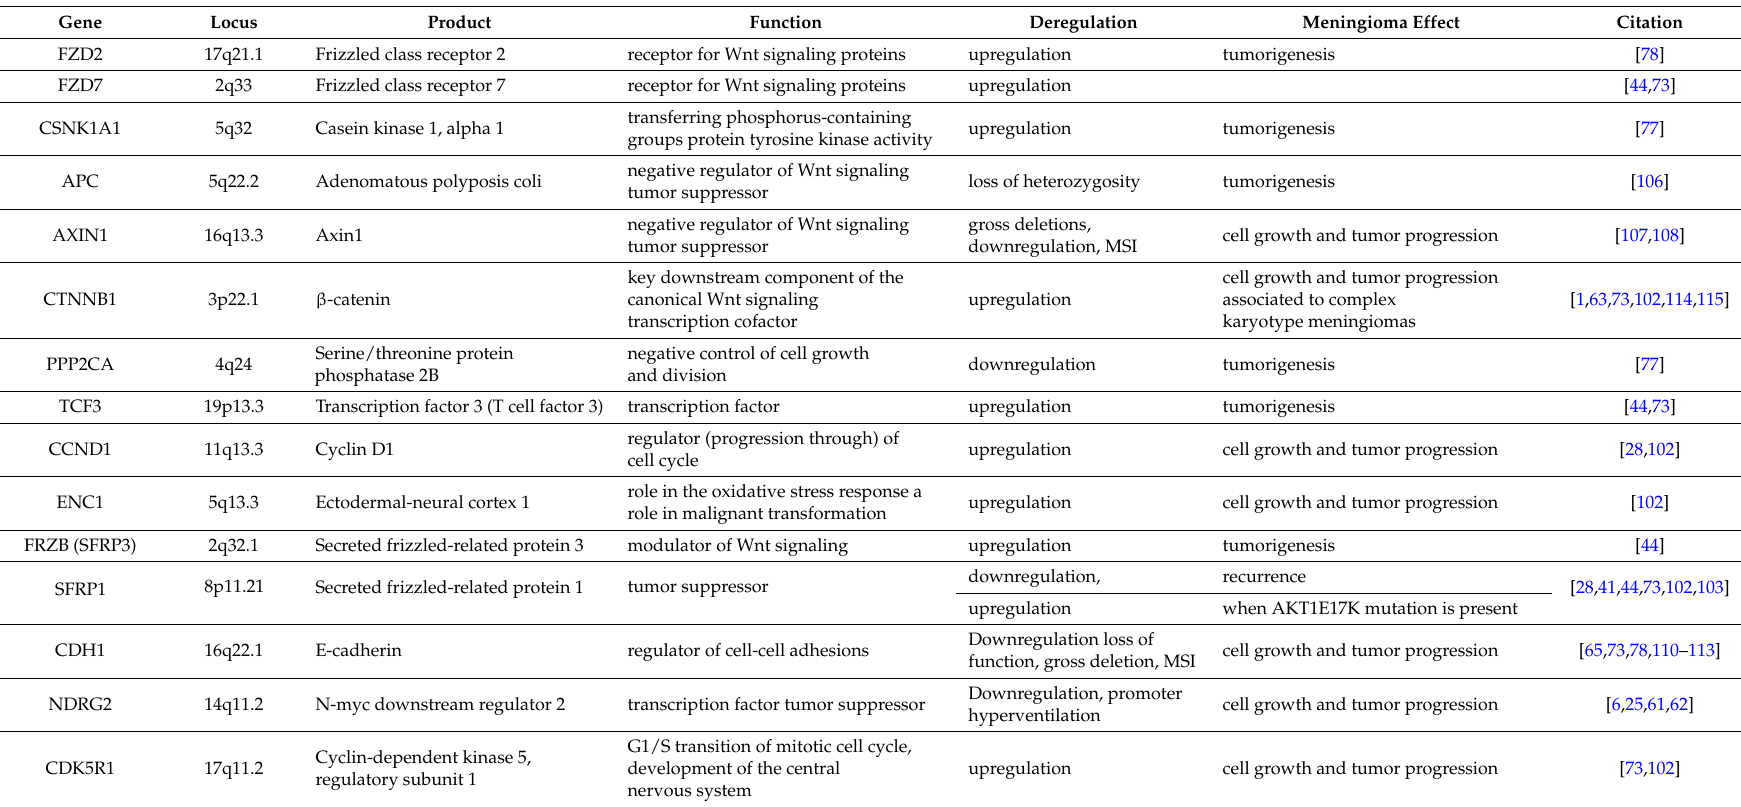
Table 2. Differentially expressed genes of Wnt signalling pathway found in